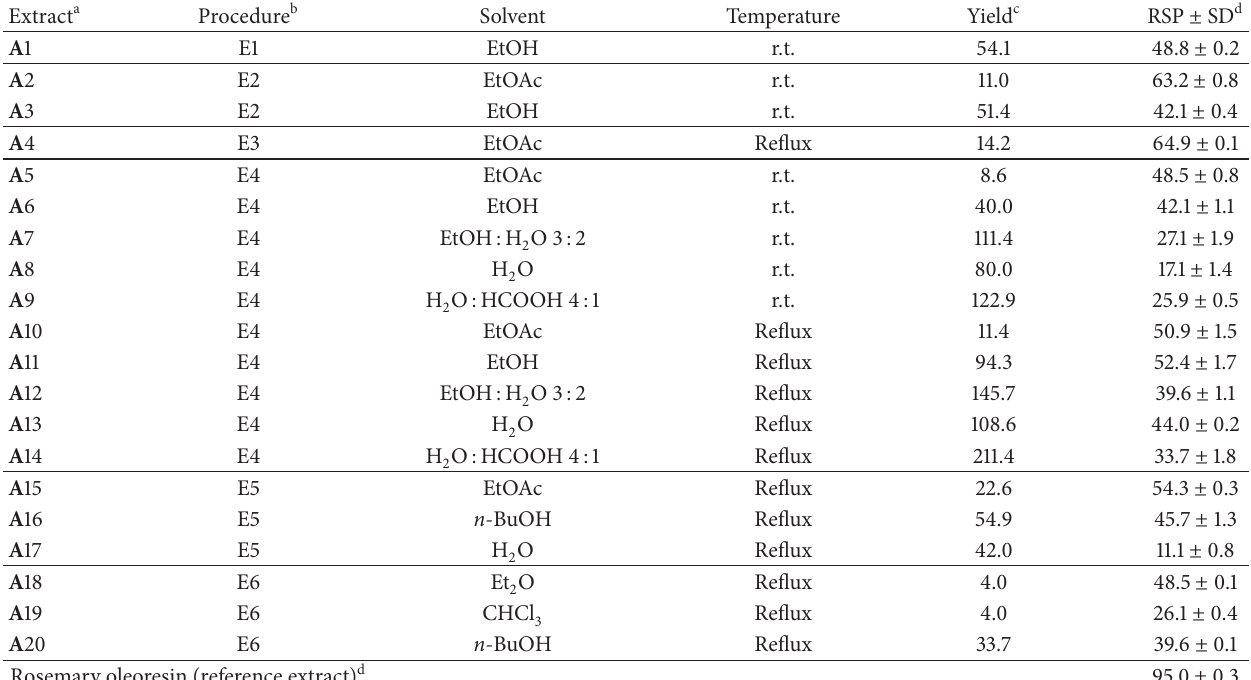
Table 2: Extraction yields and radical scavenging percentages of several extracts prepared by the extraction procedures E1–E6 from the olive wood sample A .